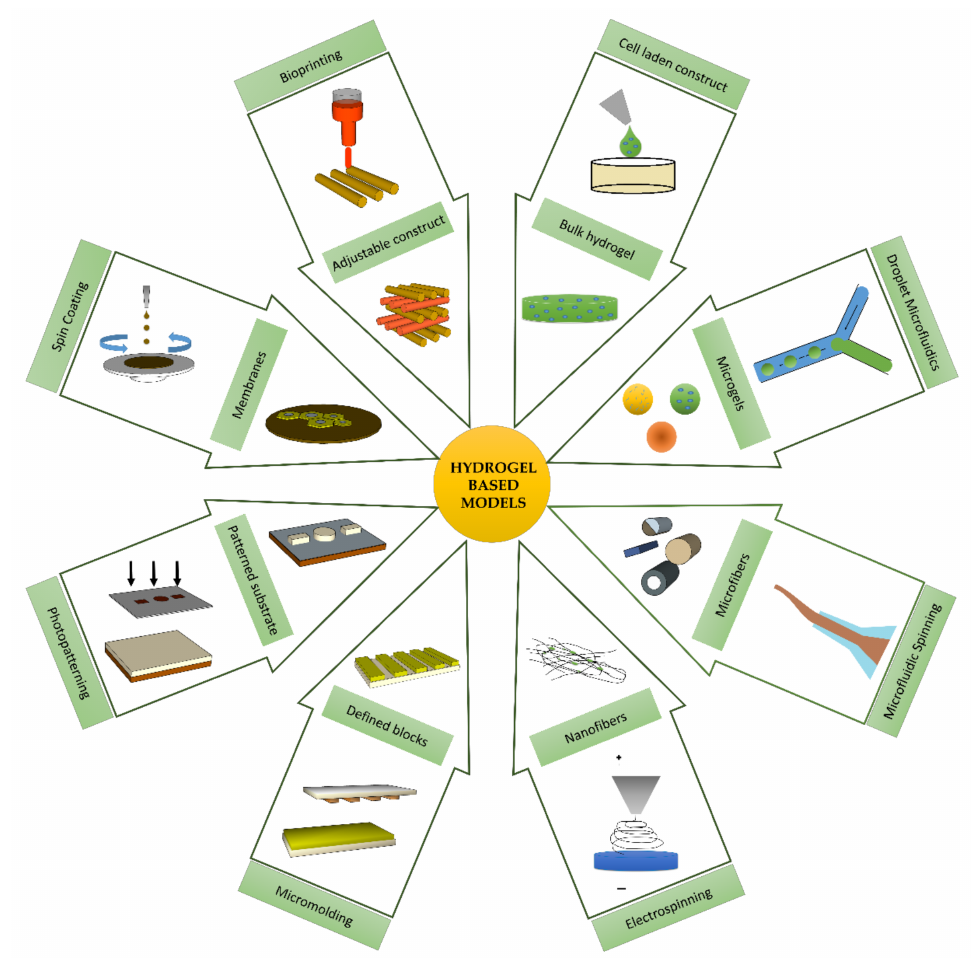
Figure 3. Schematic figure of existing fabrication technologies for designing various hydrogel